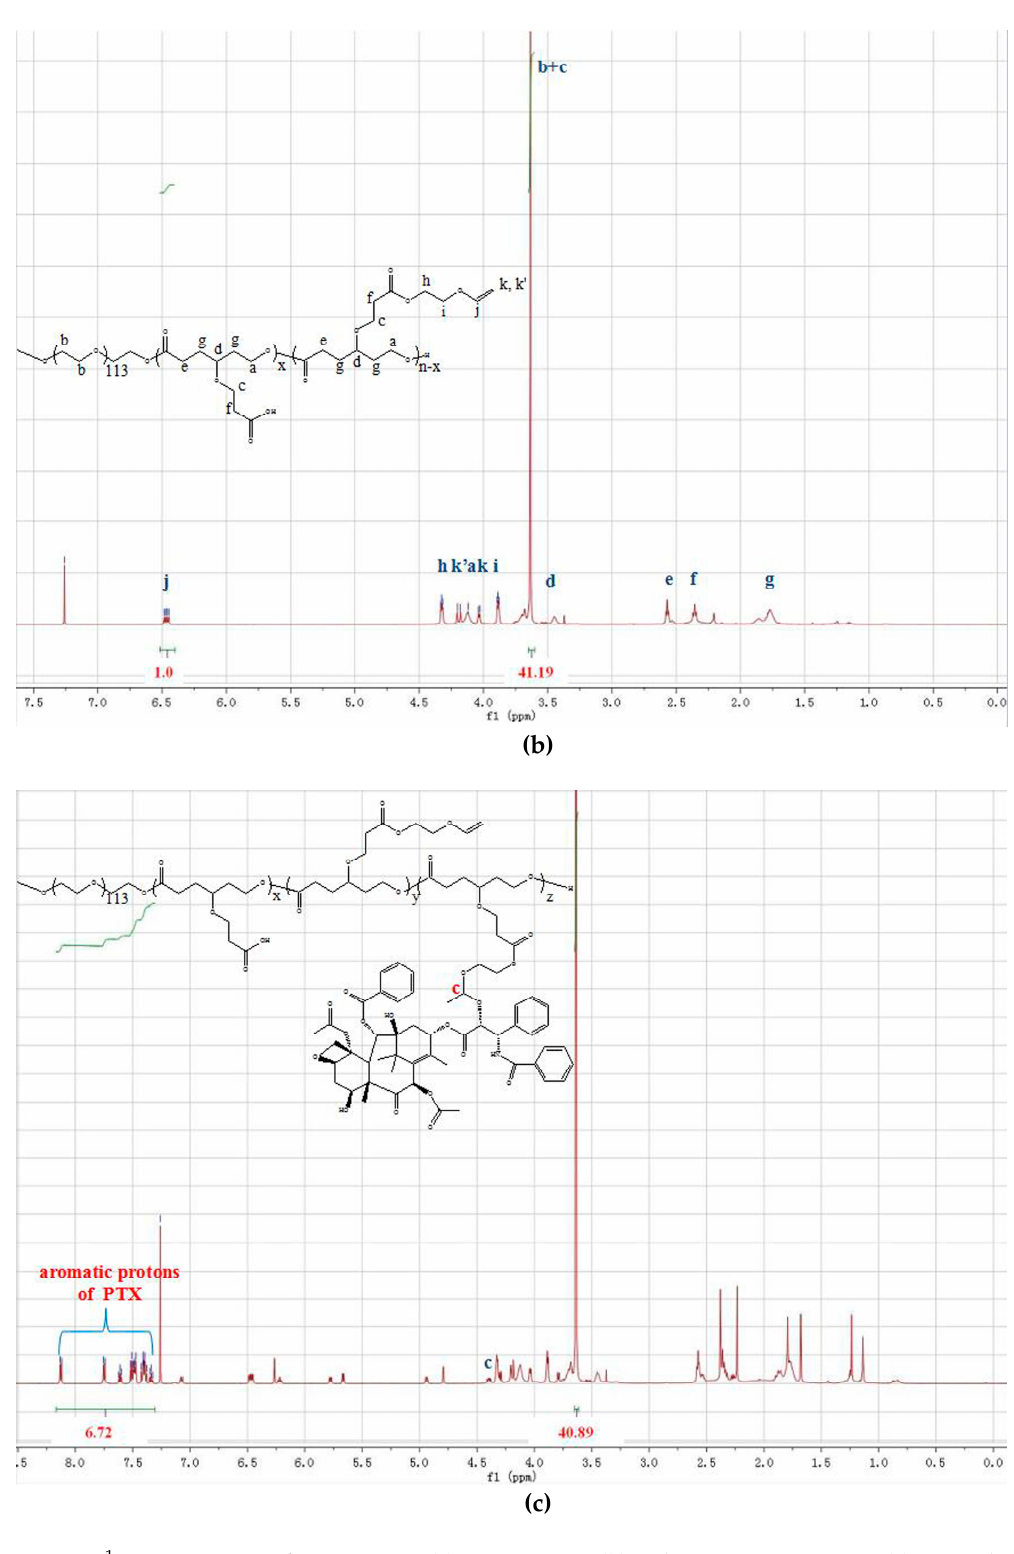
Figure 1. 1 H NMR spectra of mPEG-CPCL ( a ), mPEG-VPCL ( b ) and mPEG-PCL-Ace-PTX ( c ) in CDCl 3 .